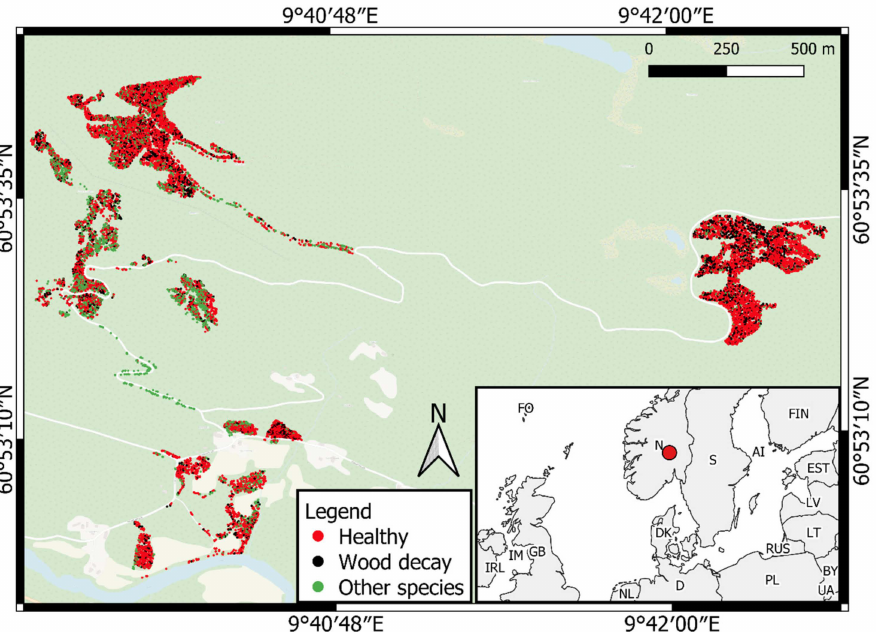
Figure 1. Dataset I: Location of the individual field trees (dots in the large map), and location of the study area (red dot in the